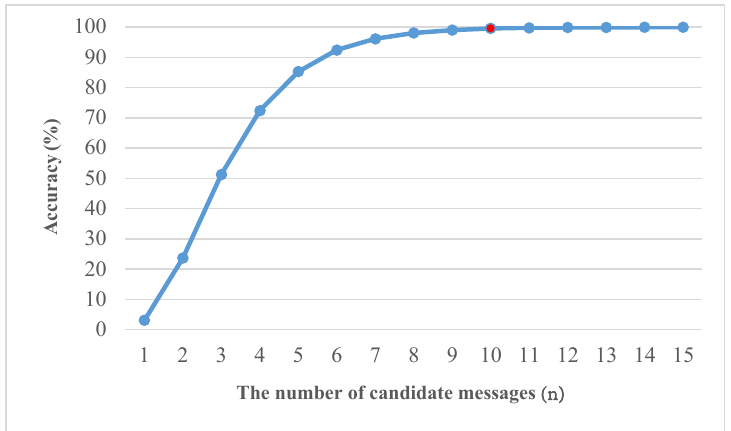
Figure 9. Accuracy versus candidate